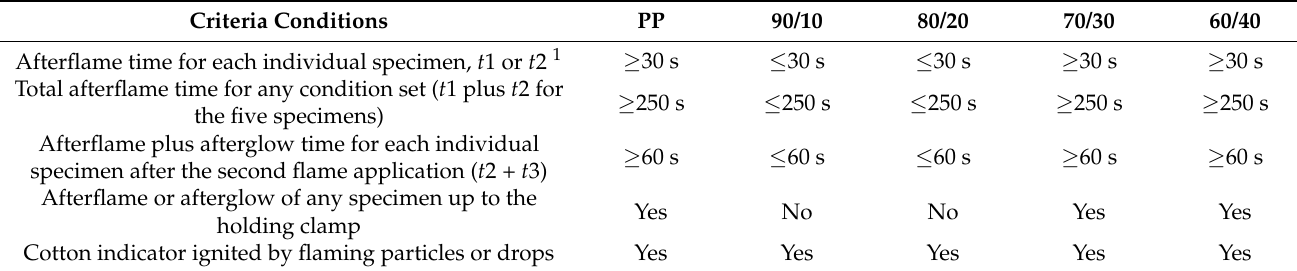
Table 2. Flammability properties of PP and its blends with LGNa